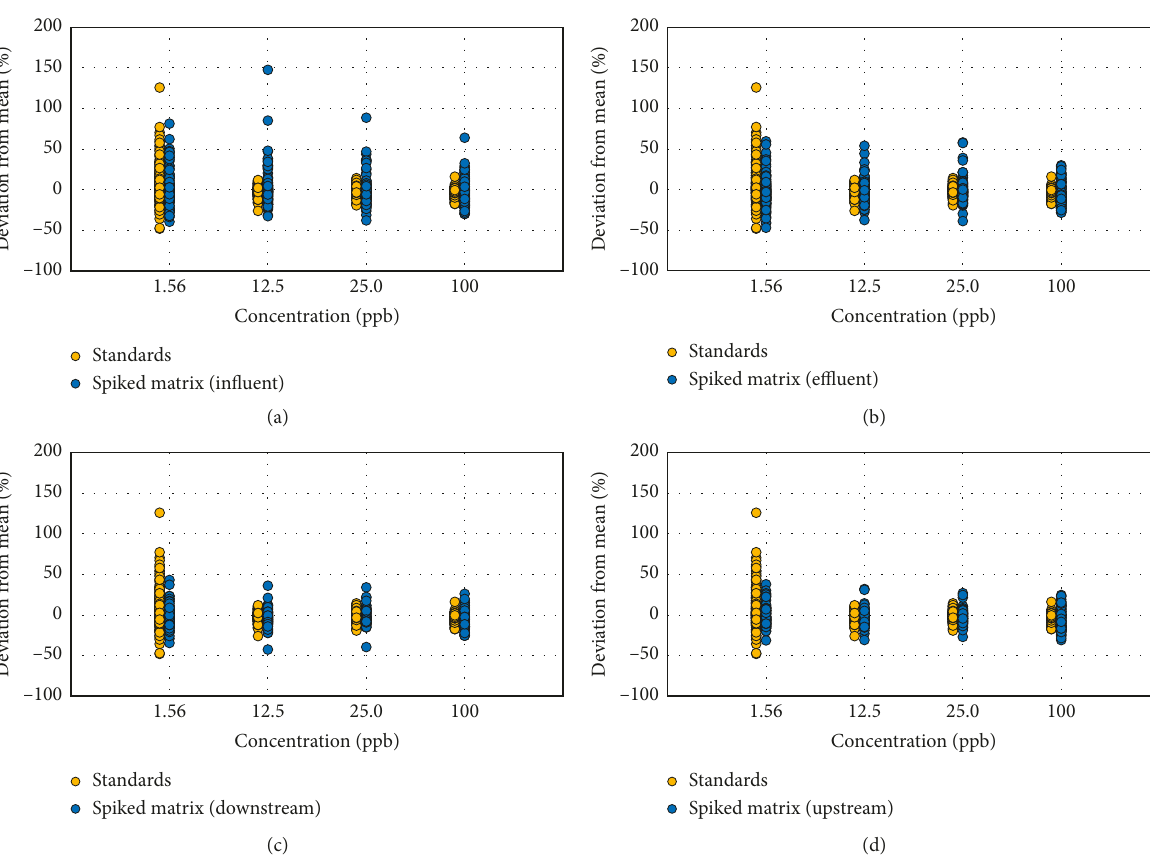
Figure 4: Comparison of ion ratios in spiked matrices and in clean standards. (a) WWTP influent samples; (b) WWTP effluent samples; (c) upstream surface water samples; (d) downstream surface water samples. Table 2: Percent false negatives in spiked environmental matrices at different tolerance ranges for all 30 PPCPs. Matrix Tolerance range Overall false negatives Influent Effluent Downstream Upstream